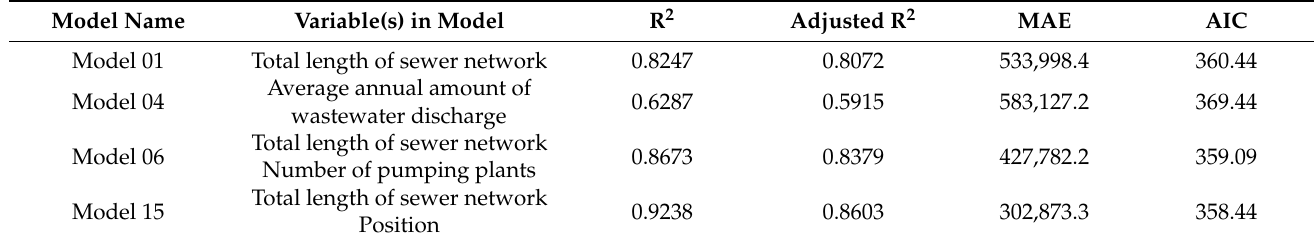
Table 12. Variables of the maintenance cost estimation model with the corresponding data.